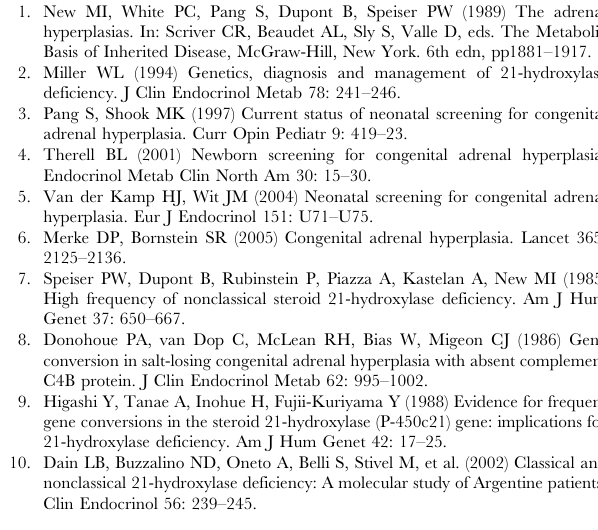
(PDF) Figure S3 Superimposition of models 2GEG (orange) and Biskit (green). For clarity, only one heme is depicted in sticks. Both models tend to be more similar in regions with secondary structure. Residues implicated in the novel mutations found, as well as D322 residue are labeled (PDF) Figure S4 Cartoon representation of the helix D. Residues 147 and 149 (in sticks) point toward opposite directions. (PDF) Table S1 Identity of the target sequence to the each template structure. PDB codes and chain identifier for the 18 template structures used along with their sequence identity to the aligned region. (DOC) Table S2 Predicted D G and in vitro enzymatic activity of 40 point mutations of human P450CYP21A2. The mutations were analyzed in silico, by means of mutagenesis modeling and stability calculations using a previously available model and our own generated one, with the protein design algorithm